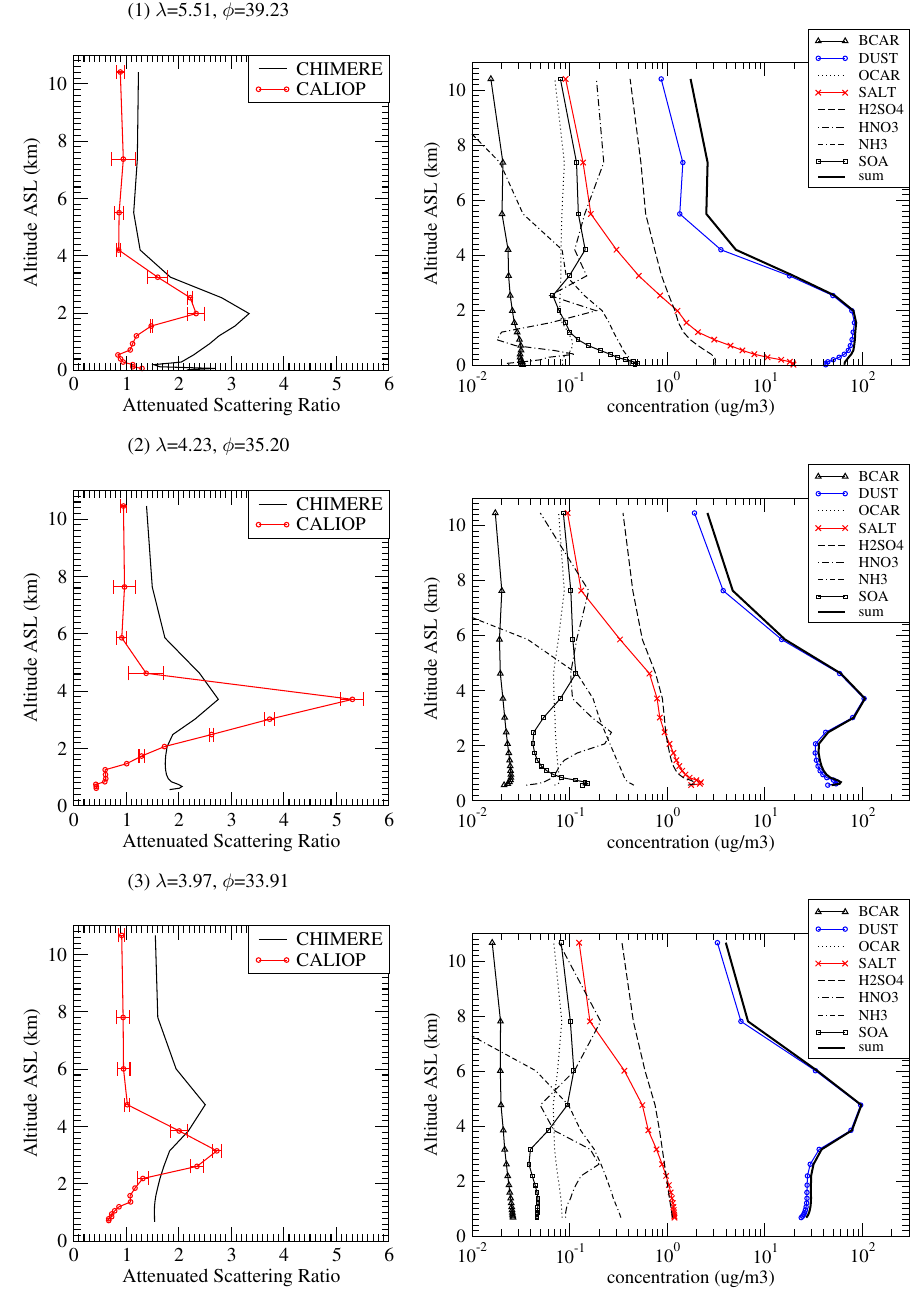
Fig. 17. Scattering Ratio profiles by CALIOP and CHIMERE (left) for the nighttime portion of the orbit the 9 July 2007 and the corresponding CHIMERE concentration profiles per species (right) .